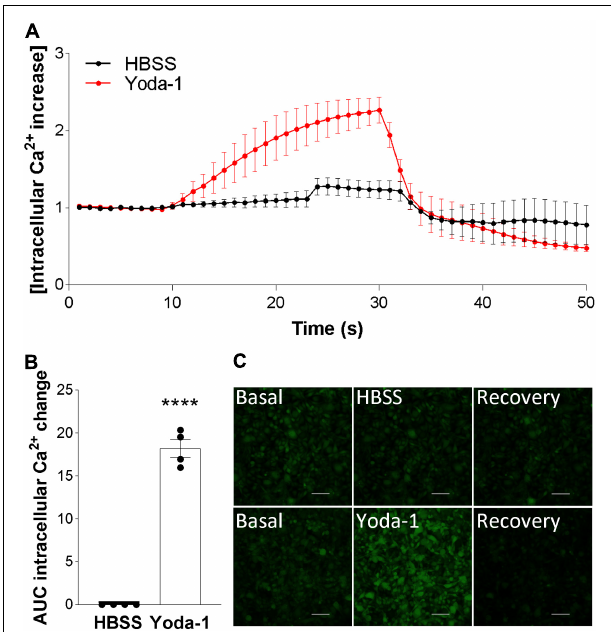
FIGURE 2 | Piezo1 agonism with Yoda-1 induces calcium signaling in MO3.13 oligodendrocytes. (A) Traces calculated from 50 s recordings show changes in Ca 2 + levels overtime after stimulation with Piezo1 agonist Yoda-1 (20 µ M) and no increase after HBSS (ctrl). Peak from t = 10 s to t = 24 s, AUC = 18.19 ± 1.49. Traces are shown as mean ± SEM of N = 4 independent experiments. (B) Corresponding bar graph shows increased Ca 2 + signaling after receptor stimulation with agonist Yoda-1. Data presented as mean ± SEM, unpaired t -test, **** p < 0.0001, N = 4 independent experiments. (C) Representative images taken from microscope recordings show basal levels of Ca 2 + , followed by induction of Ca 2 + after addition of Yoda-1 or HBSS (ctrl), and subsequent recovery. Scale 100 µ